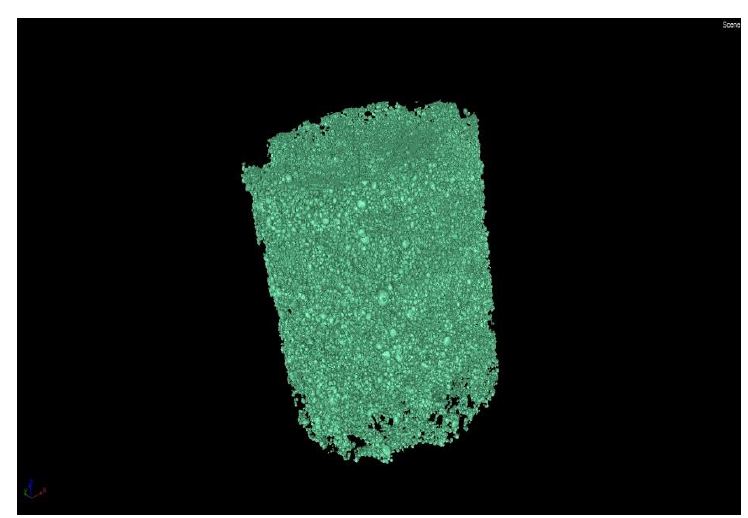
Figure 15. 3D X-ray micro-tomography views of the LAC-3 mix.